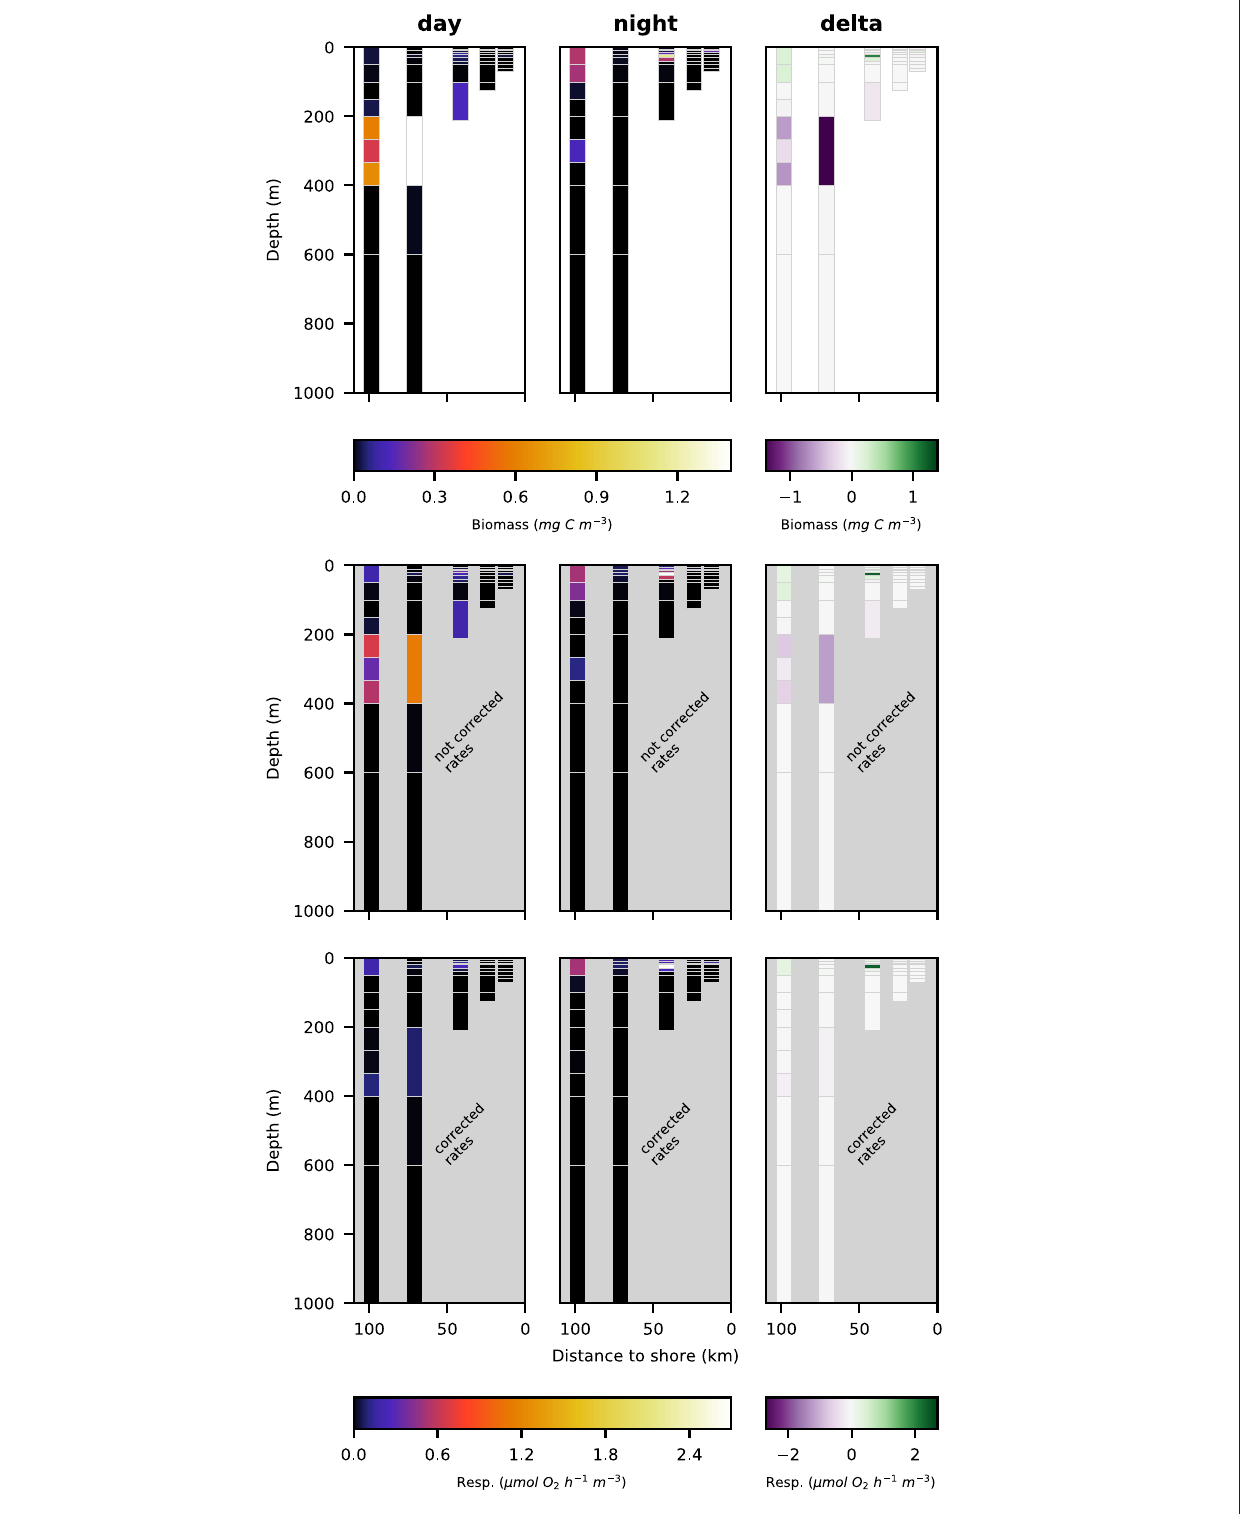
FIGURE 7 | Vertical distribution of euphausiacea biomass (top row; mg C m − 3 ), not corrected respiration rates (middle row; µ mol O 2 h − 1 m − 3 ) and corrected respiration rates (bottom row; µ mol O 2 h − 1 m − 3 ) along the transect at day (left panels), night (middle panels), and the difference of the two (right panels).